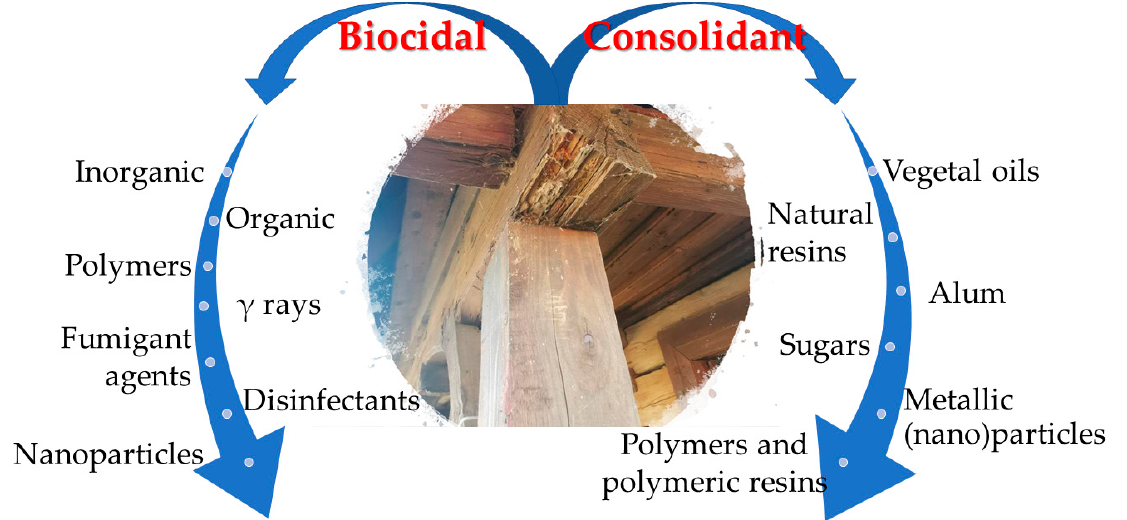
Figure 3. Aspects covered by the present review regarding the conservation and restoration of wooden building